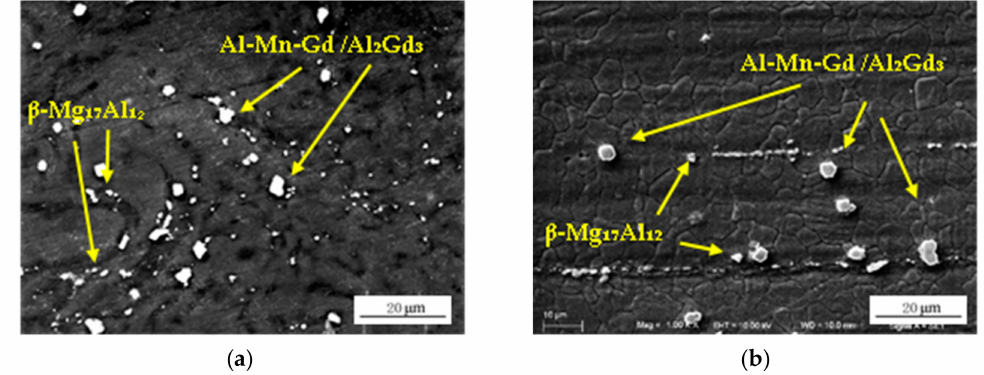
Figure 3. SEM morphology of the AM50Gd magnesium alloy. Radial ( a ) and axial ( b ) sections.